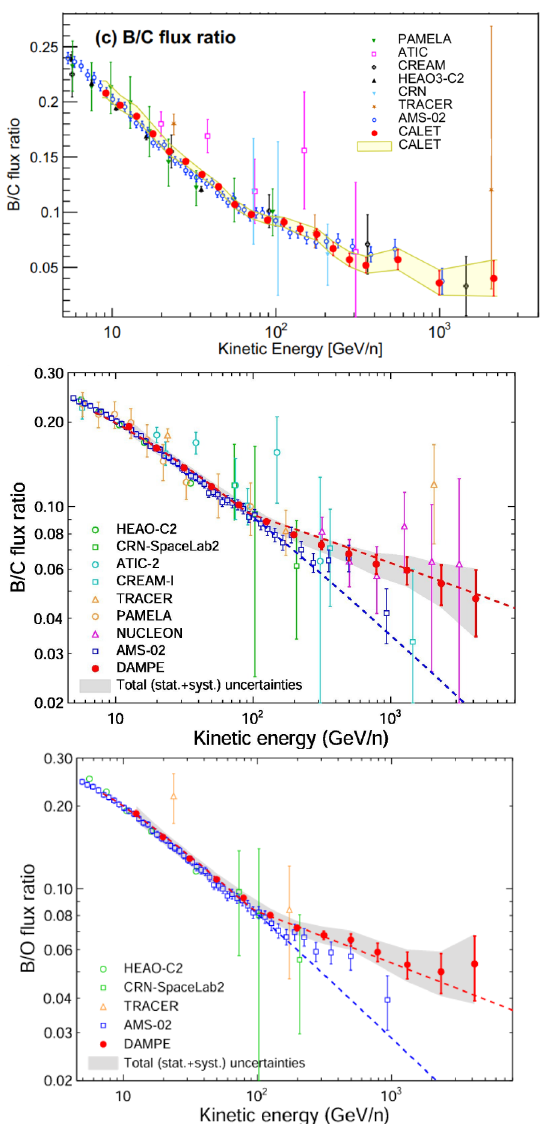
Figure 10. B / C and B / O measured by di ff erent experi- ments [22] [23].